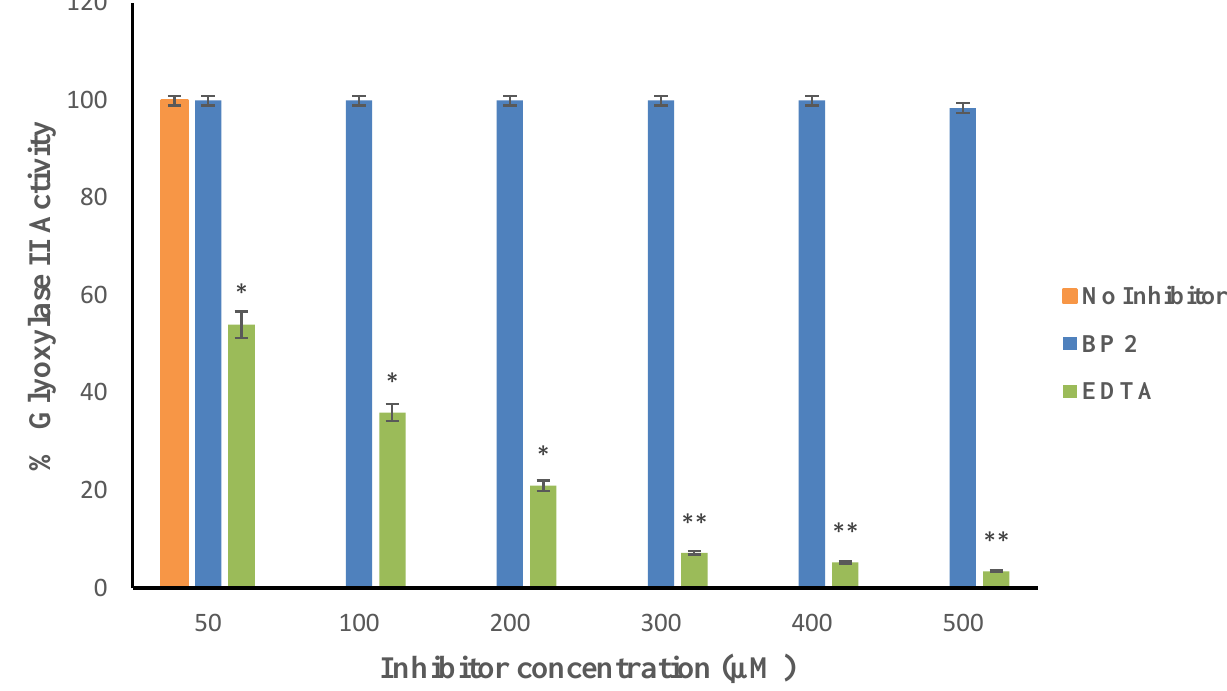
Figure 4. Glyoxylase II activity in the presence of BP2 and EDTA. Normal glyoxylase II activity is denoted by the legend representing no inhibitor added. BP2 did not decrease the activity of glyoxylase II compared to metal chelating agent EDTA. Statistical significance is denoted by p < 0.005 (*) and p < 0.001 (**) Experiment conducted in triplicate.